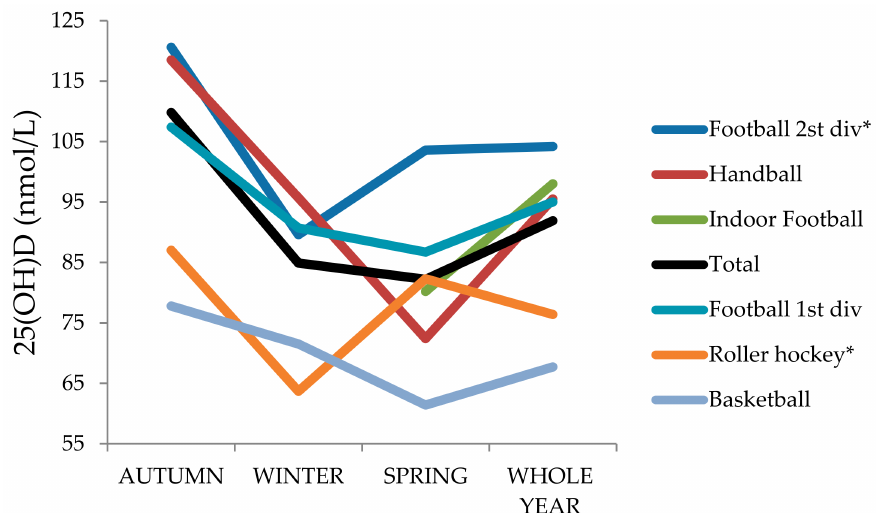
Figure 4. Mean 25(OH)D concentrations according to sport modality by season. * Football 2nd division, indoor football, and roller hockey (indoor) were fully supplemented during the whole year (100% of the